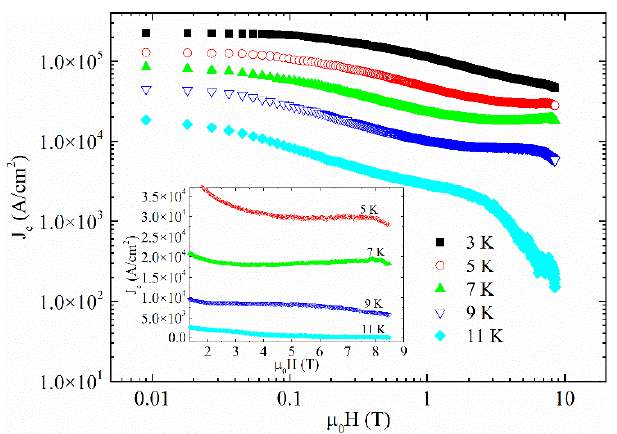
Figure 3. Critical current densities as a function of field at different temperatures. Inset: a magnification of the curves near the region of the second magnetization peak phenomenon is shown.